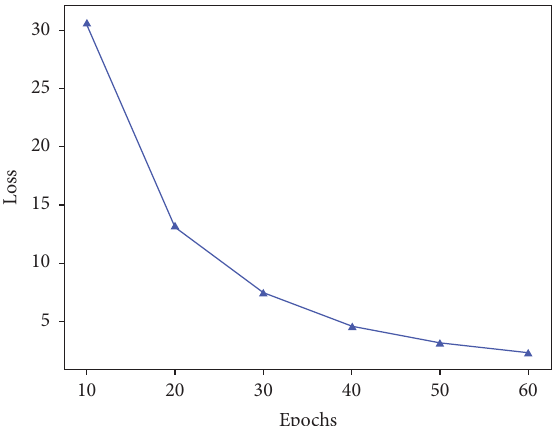
Figure 6: Te data in this fgure show the average total loss in every epoch. Te LDA2vec model can converge at 60 epochs.